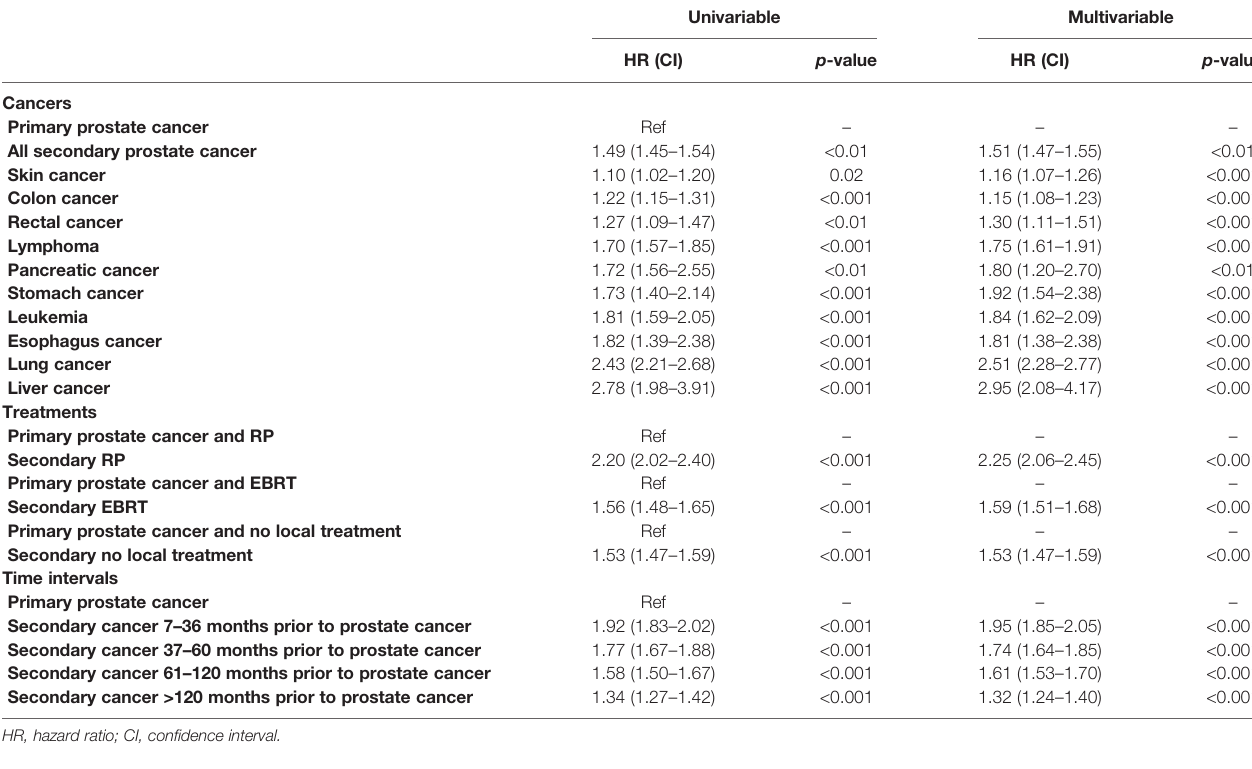
TABLE 3 | Univariable und multivariable Cox regression models after adjustment for PSA, socioeconomic status, Gleason grade group, and D ’ Amico risk strati fi cation.